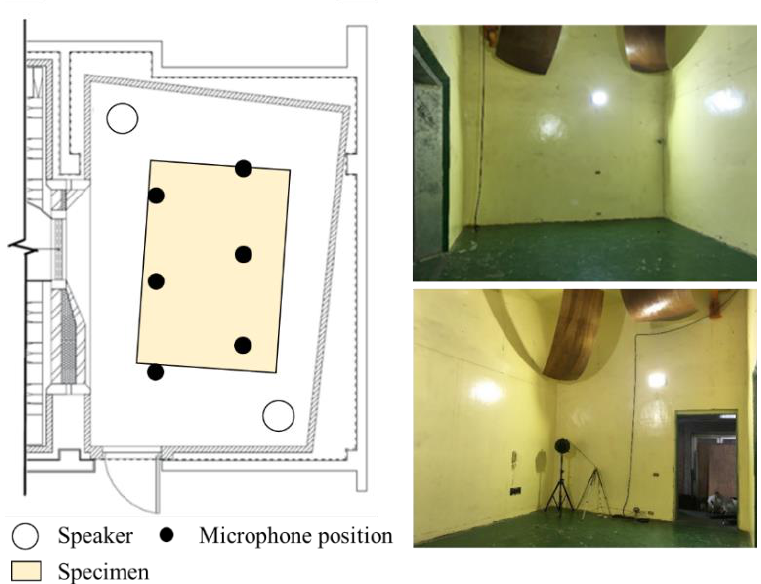
Figure 5. The installed position of the specimen in the reverberation room.